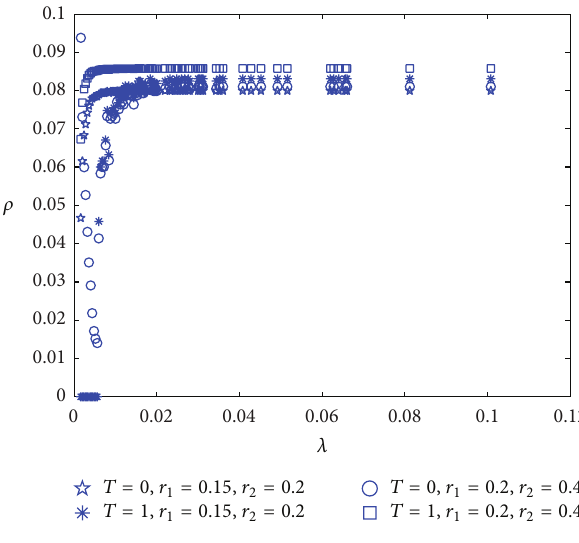
Figure 3: Changes in the contagion density 𝜌 as a function of changes in the effective spreading rate 𝜆 in the limited scale-free